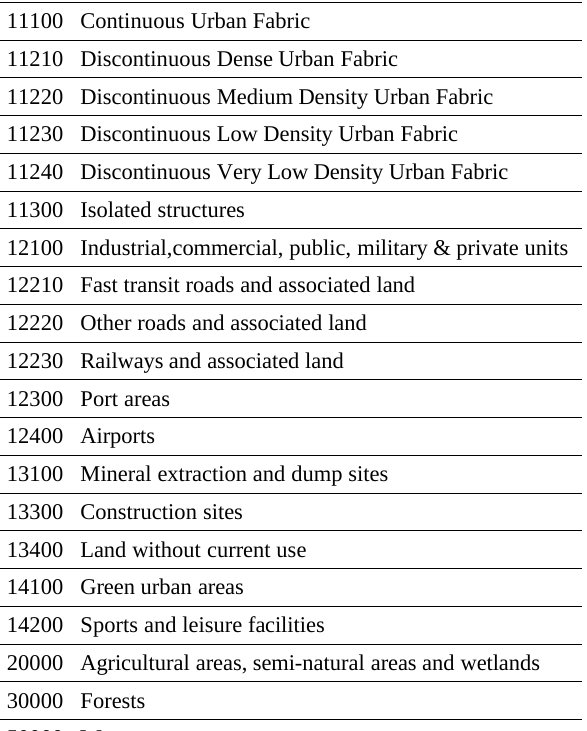
Table 1. Land use classes in Urban